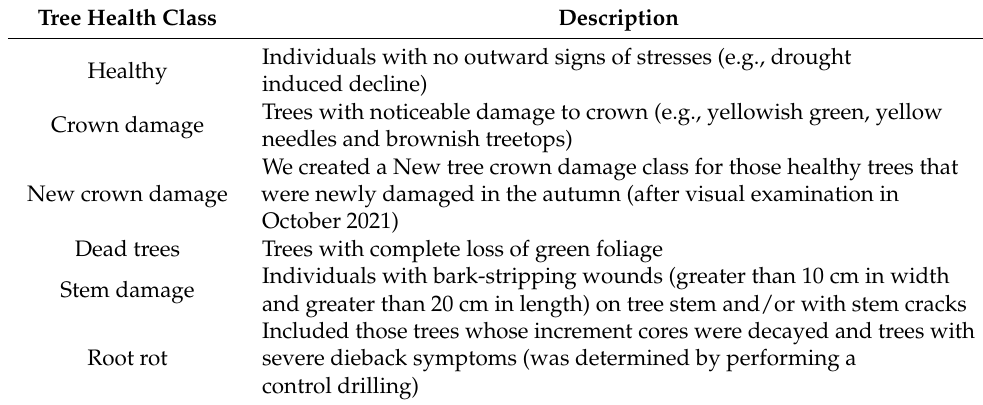
Table 3. Description of allocated tree health